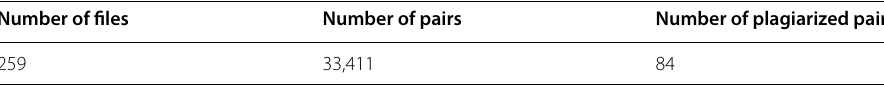
Table 4 The number of files and pairs of